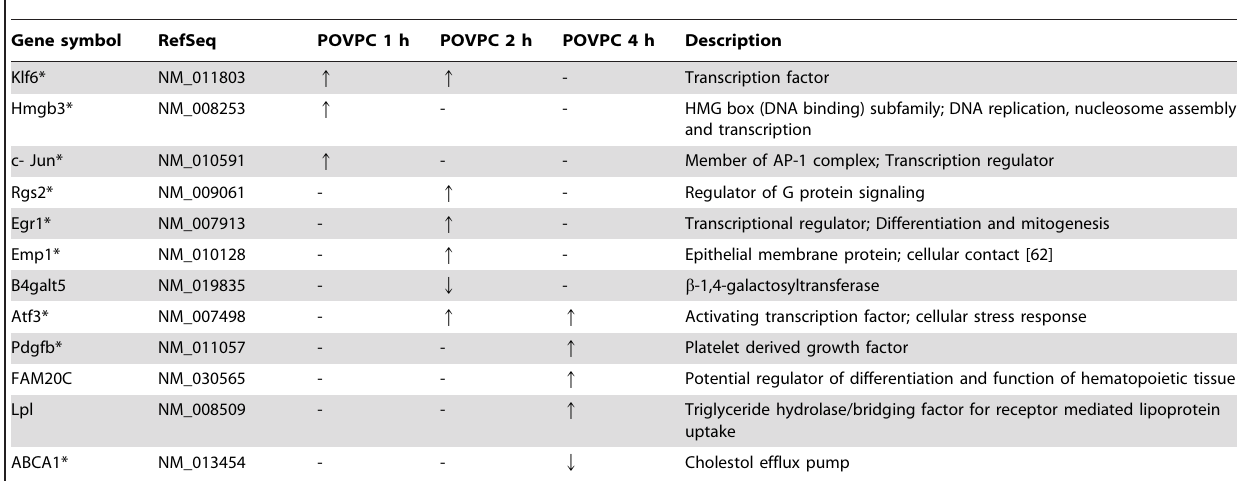
Table 1. Time-dependent transcriptional effects of 50 m M POVPC in RAW 264.7 macrophages as observed with microarray